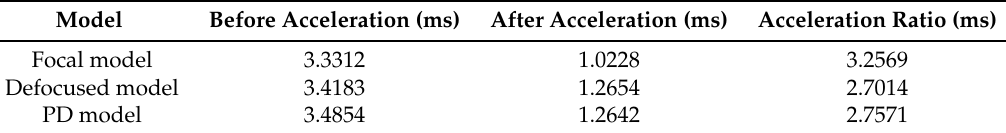
Table 6. The average inference time of PD-CNN models for 3000 samples on Jetson AGX Xavier.